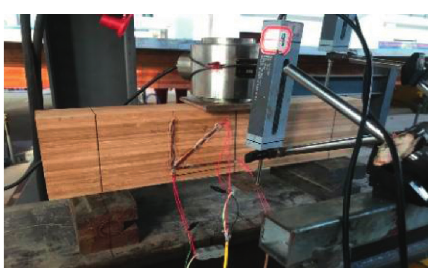
Figure 9: Diagram of one-point loading configuration. Figure